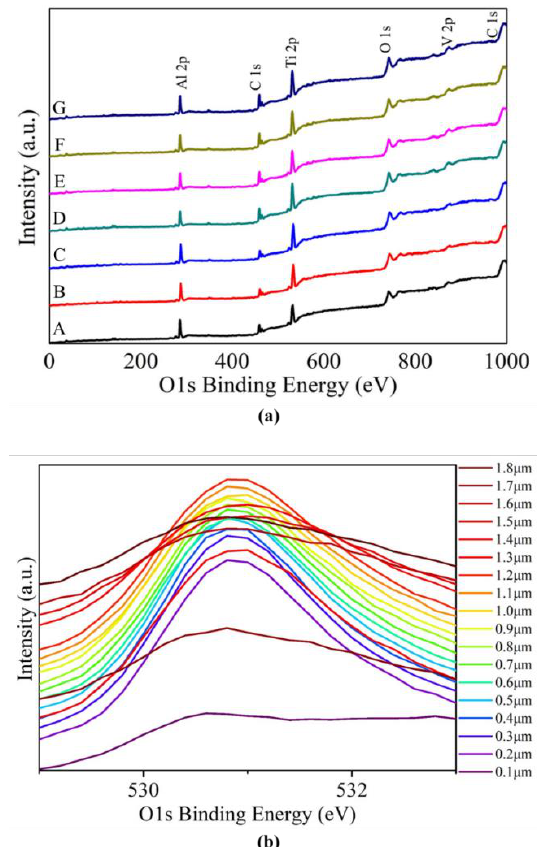
Figure 8. ( a ) XPS-spectra of the present specimen A – G, revealing that Al2 p , C1 s , Ti2 p , O1 s , and V2